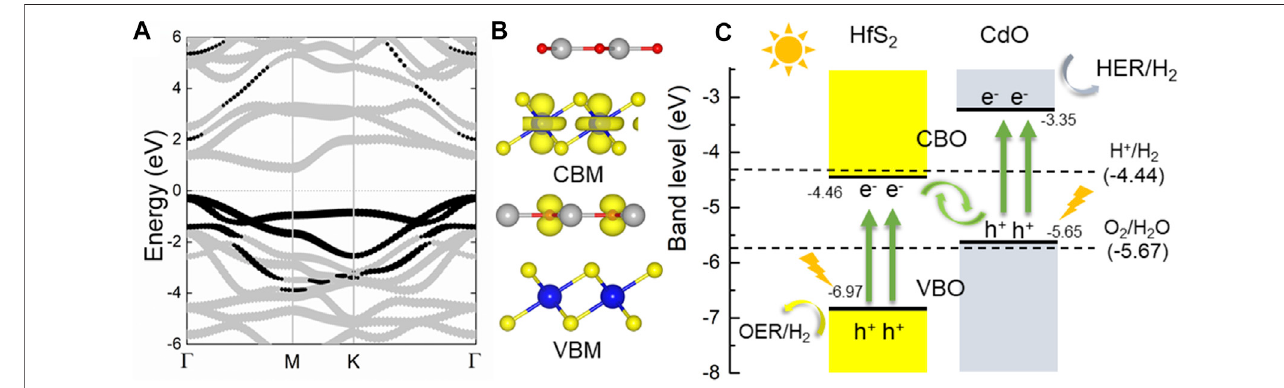
FIGURE 3 | The (A) projected band structure, (B) band-decomposed charge densities, and (C) band alignment of the CdO/HfS 2 vdW heterostructure compared with the oxidation and reduction of water splitting at pH 0; the Fermi level is set to 0.